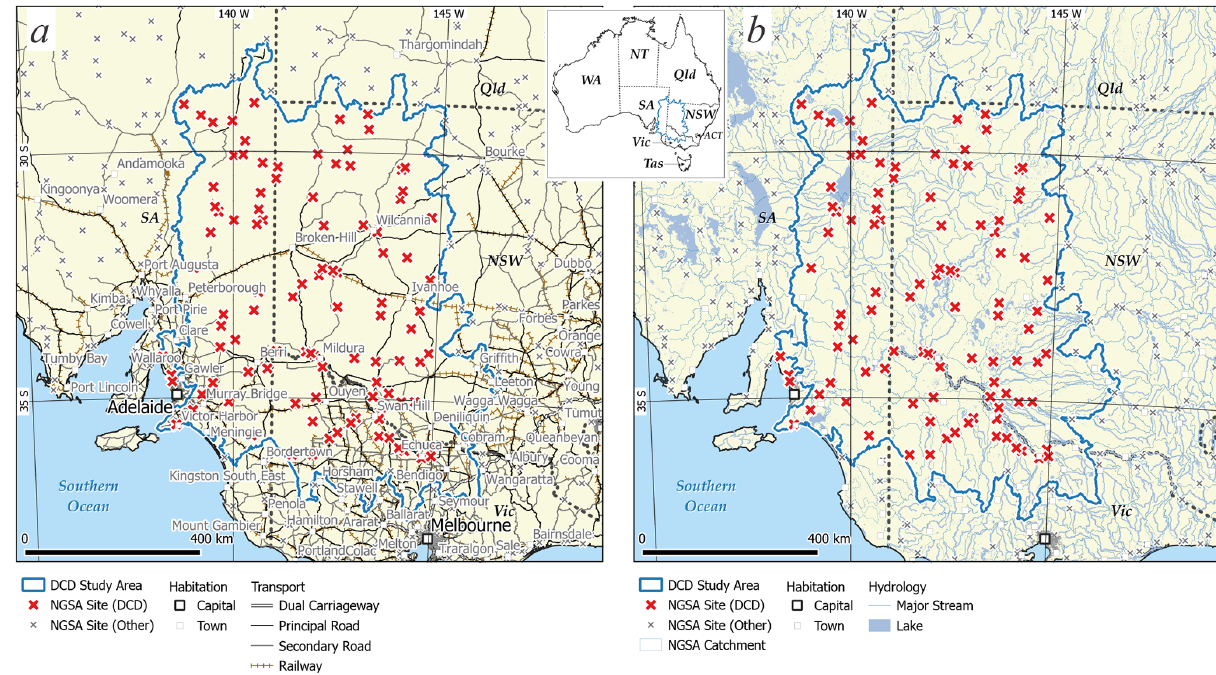
Figure 1. The Darling–Curnamona–Delamerian (DCD) Sr isotope study area (dark blue outline, see inset for location: WA – Western Australia, NT – Northern Territory, Qld – Queensland, NSW – New South Wales, ACT – Australian Capital Territory, Vic – Victoria, Tas – Tasmania, and SA – South Australia) and National Geochemical Survey of Australia (NGSA) sample locations (crosses) shown with (a) townships (squares), roads (black or grey), and railway (brown); and (b) NGSA catchment boundaries (medium blue), major streams, and lakes (pale blue). Map projection: Albers equal